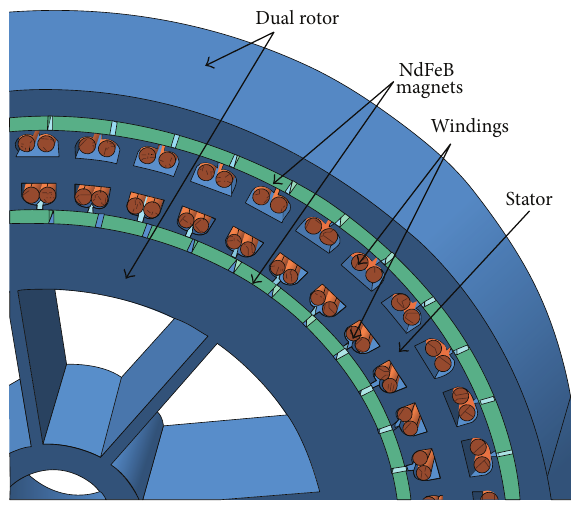
Figure 1: Three-dimensional view of DRFPMG section.